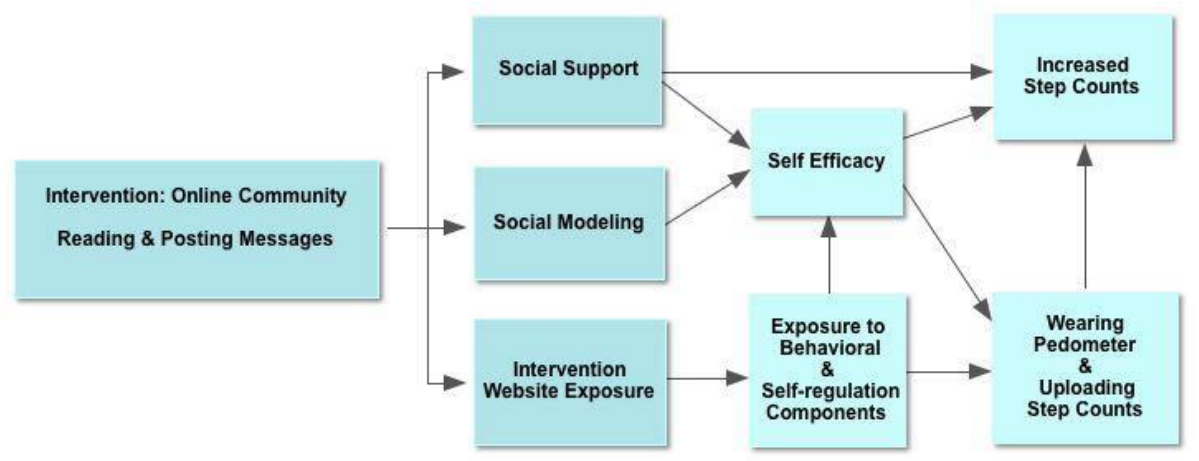
Figure 2. Conceptual